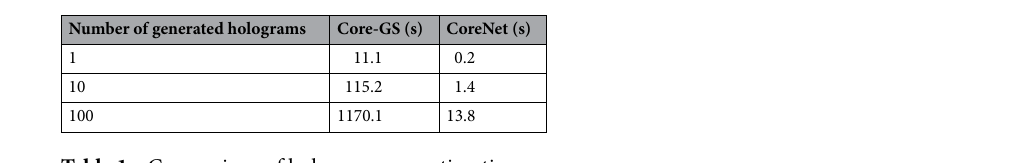
Table 1. Comparison of hologram generation